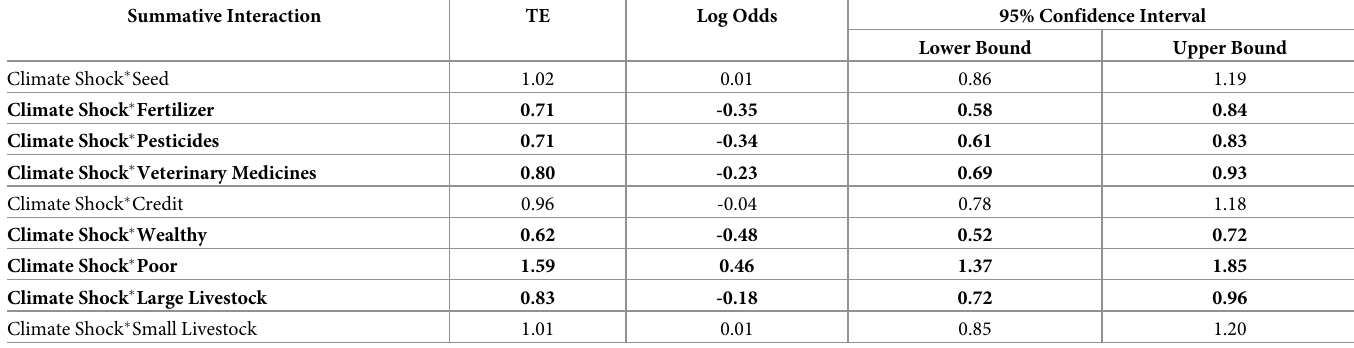
Table 3. Summative interaction effects (e.g. considered in the context of main effects) from multi-level hierarchical random effects models. Positive log odds indi- cate greater odds of food insecurity, while negative log odds indicate greater odds of food security. Results that are statistically significant within a 95% credibility interval are bolded for